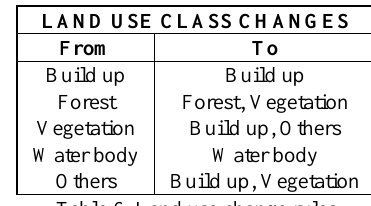
Table 6. Land use change rules